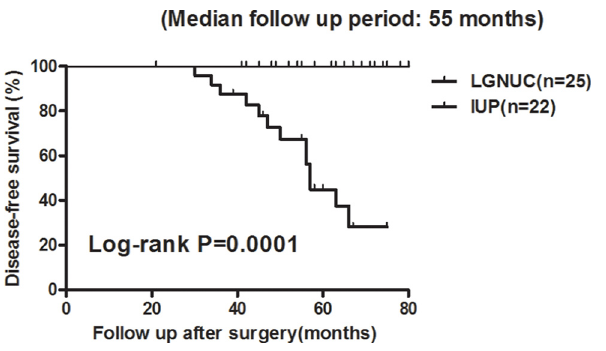
Fig 5. Comparison between the DFS of the IUP group and that of the LGNUC with an inverted growth pattern group.